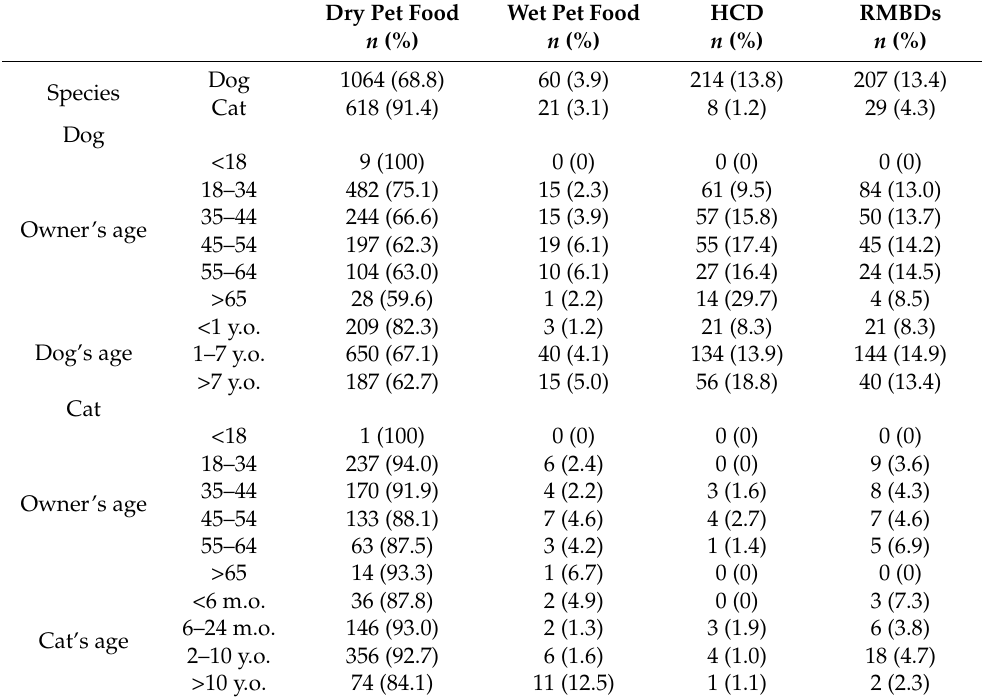
Table 4. Distribution of the types of diets offered to dogs and cats ( n /%) based on owner’s and pet’s